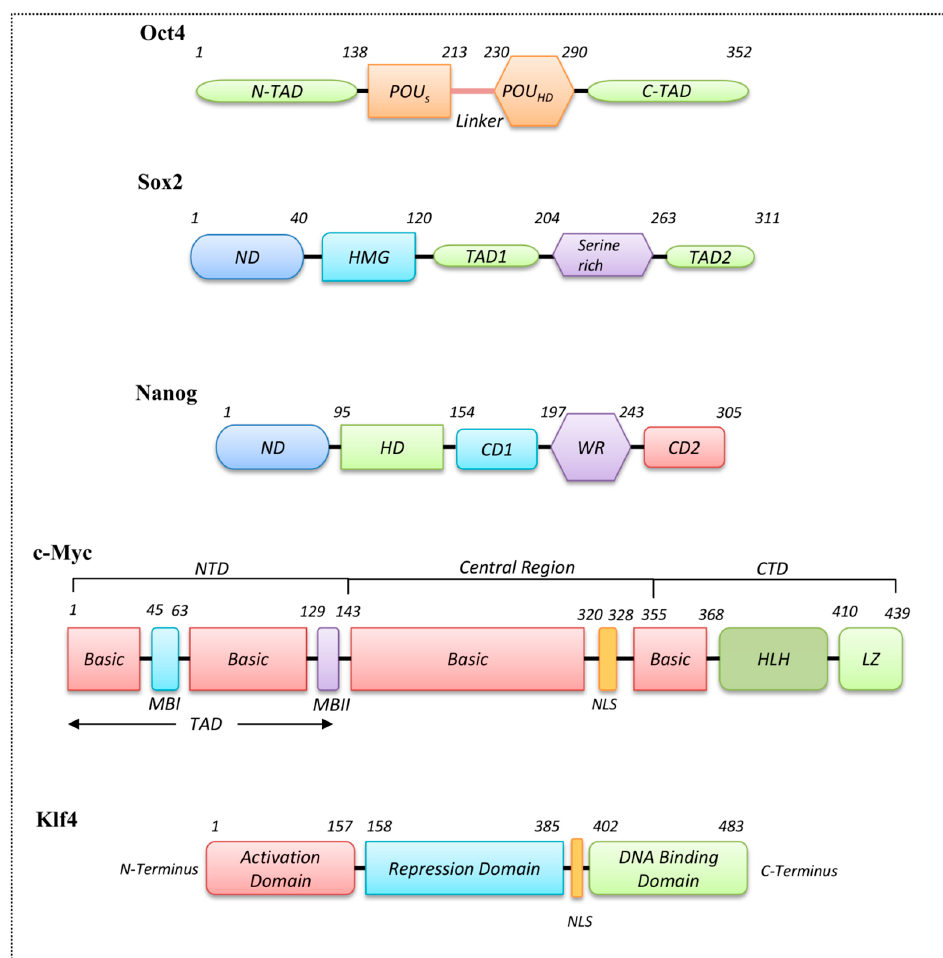
Figure 3. Domain architectures of stem cell transcription factors. A representation of the arrangement of functional domains in stem cell transcription factors Oct4, Sox2, Nanog, c-Myc, and Klf4 are shown. Each domain is marked with the length of its corresponding amino acid sequence.